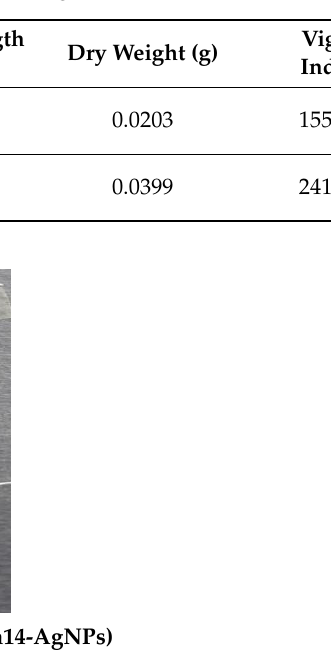
Table 7. Oryza sativa seed germination after treatment with Bs-AgNPs.